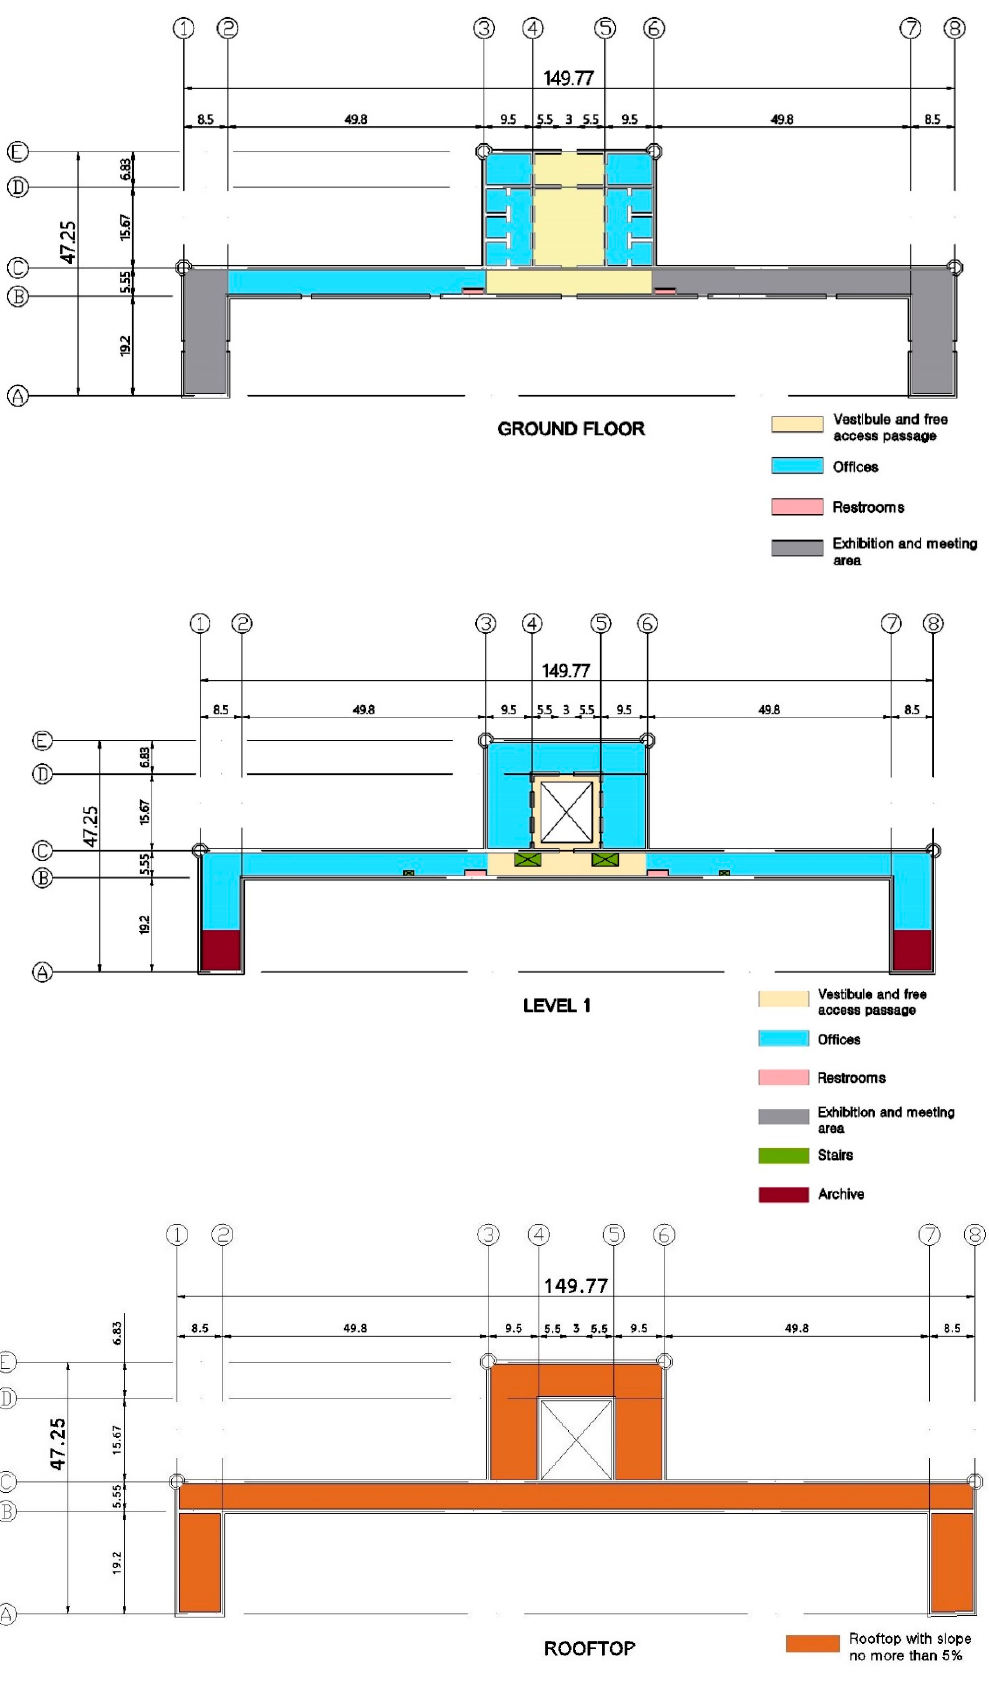
Figure 7. AGN Government Building floor-use [12].